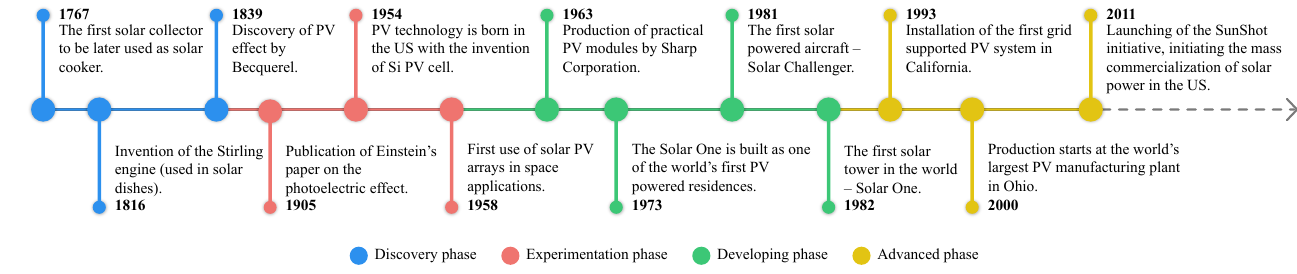
Figure 4. Solar energy timeline classified into four